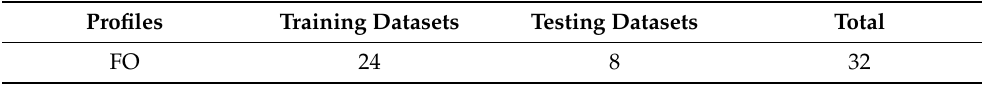
Table 1. Profile creation by